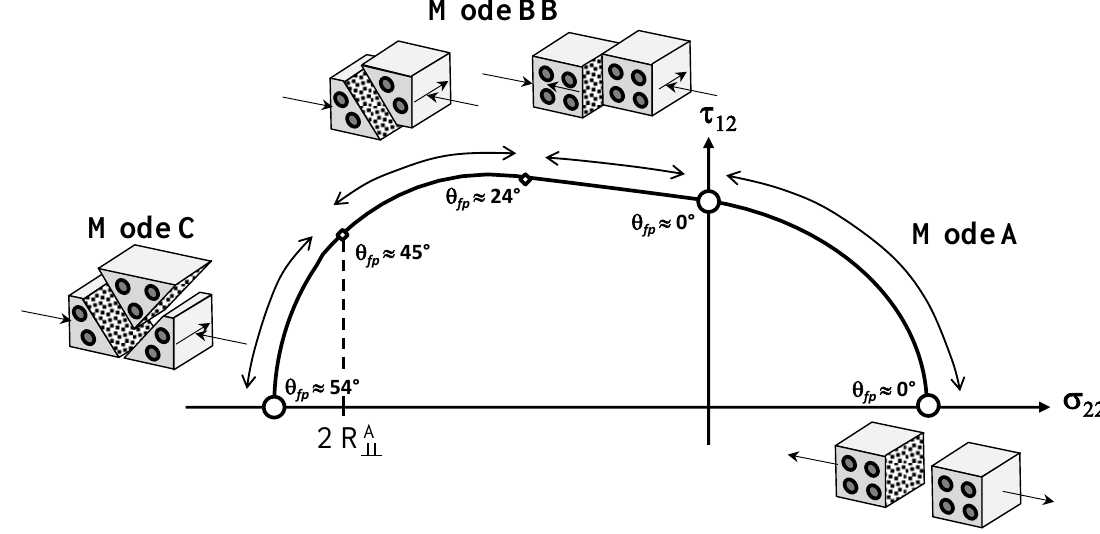
Figure 6. Proposed fracture curve on the stress space σ 22 × τ 12